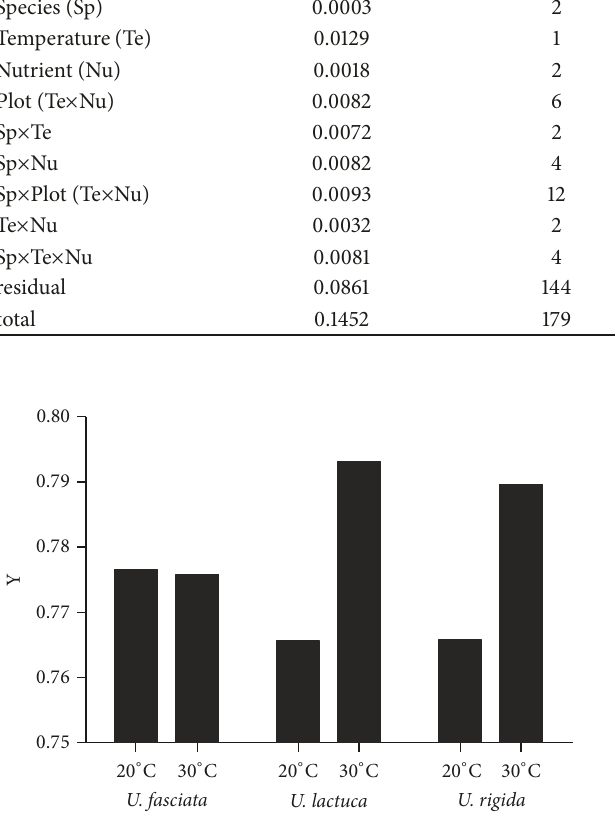
Figure 1: Photosynthetic capacities of the three species of Ulva under two temperature conditions (based on the effective quan- tum yield of PSII measurements). Data from different nutrient conditions and plots (Erlenmeyer flasks where individuals were incubated) were pooled. n=30. Standard deviation values are not shown because of scale-bar limitation (left to right: 0.021, 0.023, 0.032, 0.019, 0.026, and